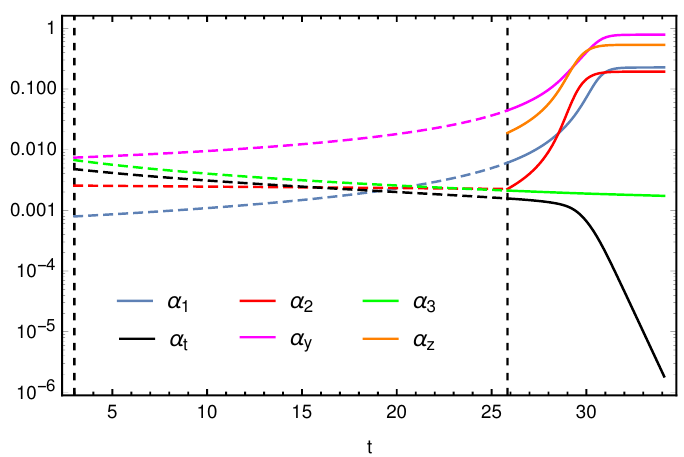
Figure 8 . Evolution of the couplings with t for the (cid:12)xed point in table 11 within the 210 approxi- mation with 3 (cid:12)elds in (1 ; 2 ; 3 = 2) and 8 (cid:12)elds in (1 ; 5 ; 0). This running provides a trajectory in the theory space connecting the (cid:12)xed point to a matching scale around 2 TeV passing through another matching (for the quintuplets) at about 10 13